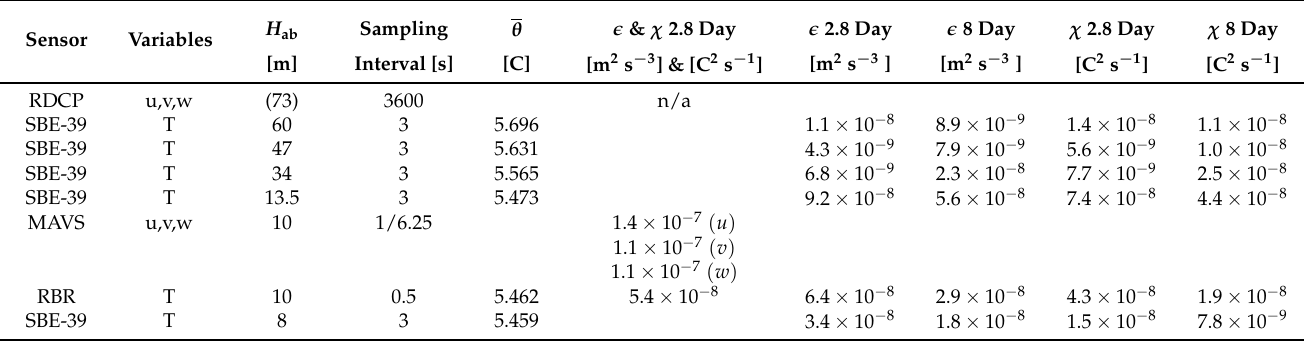
Table 1. Table of sensor depths, sampling intervals, mean temperature and dissipation estimates. Turbulent kinetic energy dissipation rate estimates ( (cid:101) ) in column 6 are derived from (10) and the temperature variance dissipation rates ( χ ) are obtained via (11) using those (cid:101) estimates. In other columns, dissipation rate estimates use (13) and assume a dissipation ratio Γ = 0.2. The MAVS-RBR χ /2 is a factor of five smaller than the production band estimate, 1.4 × 10 − 7 C 2 s − 1 . See text for further details. Estimates are quoted for 2.8 day and 8-day time